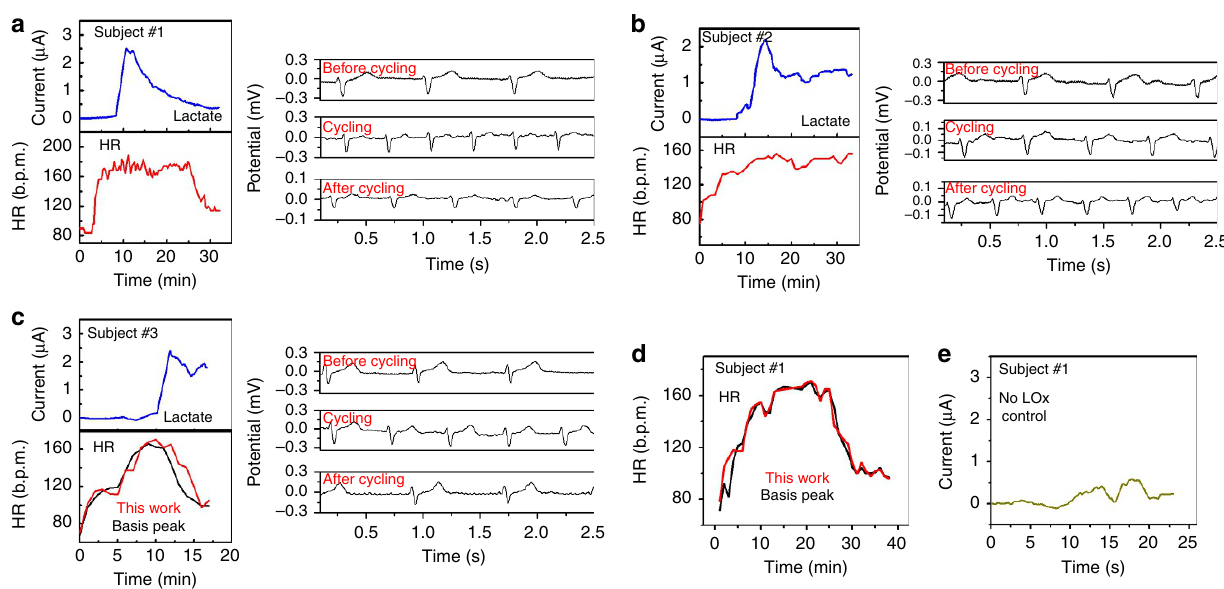
Figure 4 | Real-time on-body evaluation of the Chem–Phys hybrid patch showing the lactate levels and heart rate for three human subjects. ( a – c ) The corresponding blue plots represent the real-time lactate concentration profiles for each subject, while, the red plots depict the heart rate data obtained by the electrocardiogram electrodes of the Chem–Phys patch. The black plots correspond to the heart rate data recorded by the Basis Peak heart rate monitor. Typical real-time electrocardiogram data obtained before, during and after the cycling bout for each subject is also shown. ( d ) Additional heart rate data from subject #1. ( e ) Response of the control amperometric sensor (without LOx enzyme) for subject